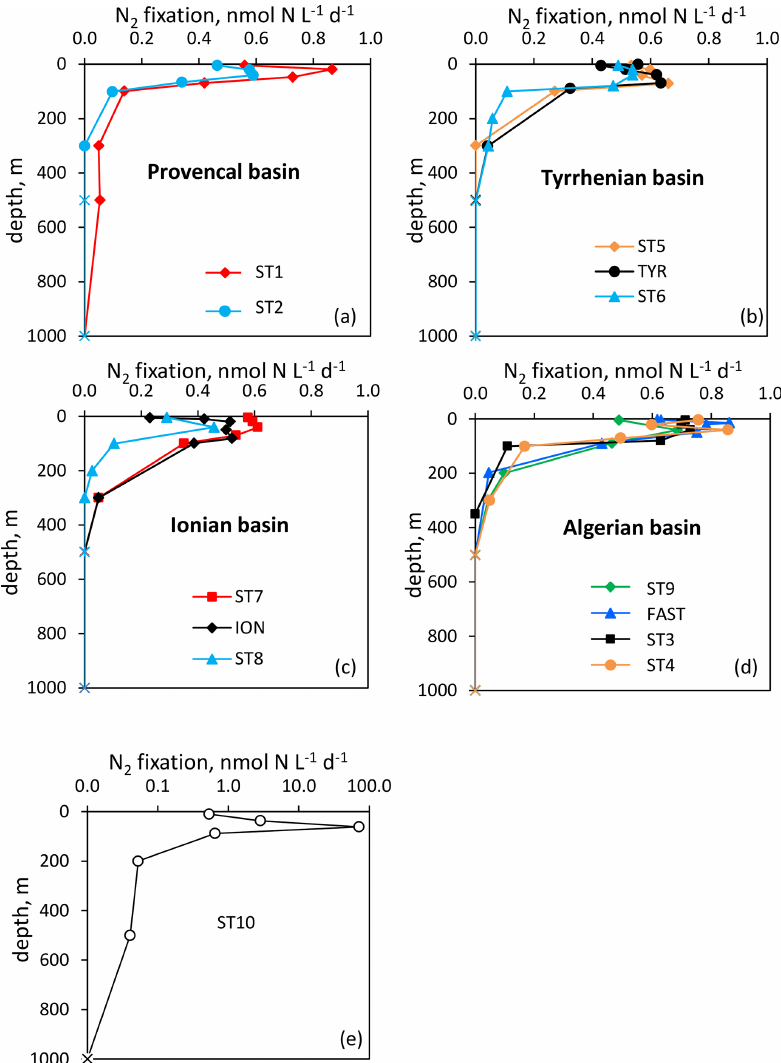
Figure 2. Vertical distribution of N 2 fixation (in nmolNL − 1 d − 1 ) in the Provencal (a) , Tyrrhenian (b) , Ionian (c) and Algerian (d) basins and at Station 10 (e) . N 2 fixation rates at Station 10 are plotted in log scale because of the high fluxes. Rates under the detection limit ( < 0.04nmolNL − 1 d − 1 ) are symbolized by